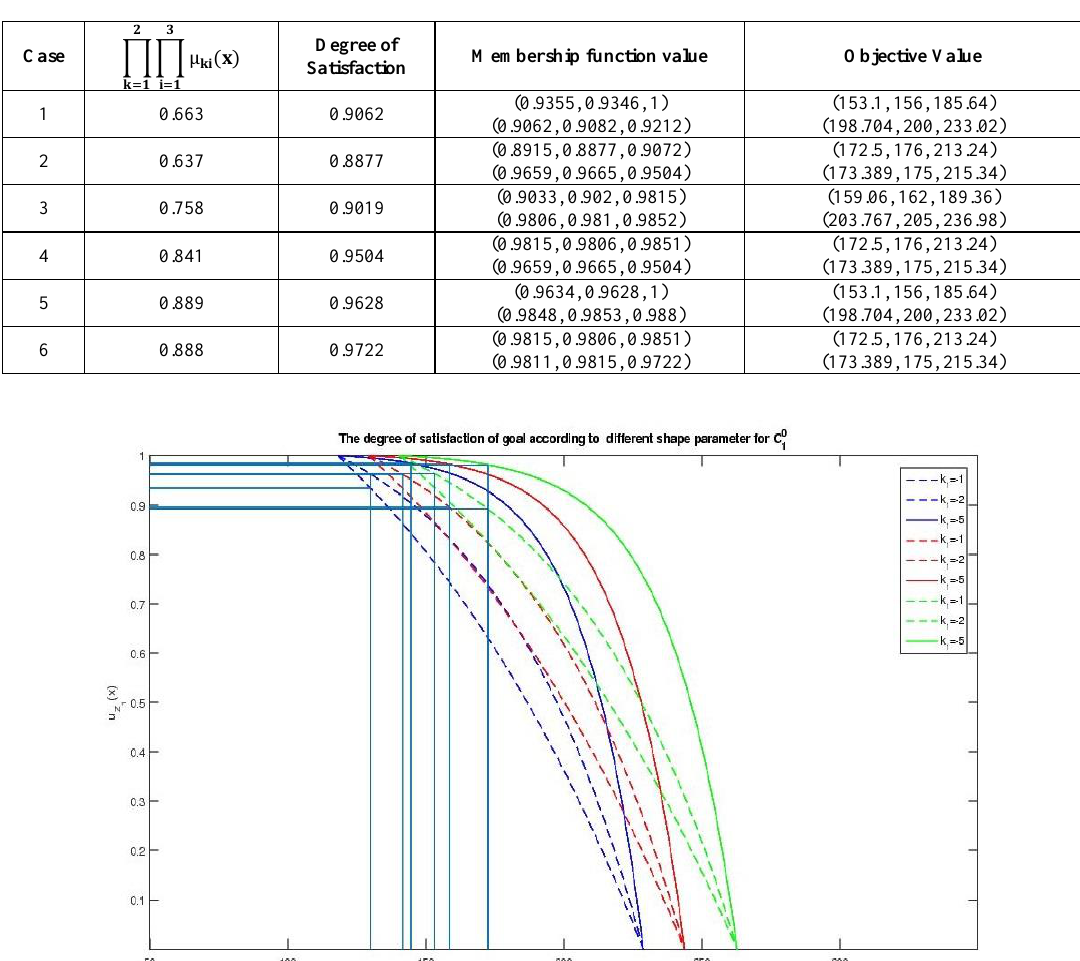
Table 5. Summary results for α = 0.9